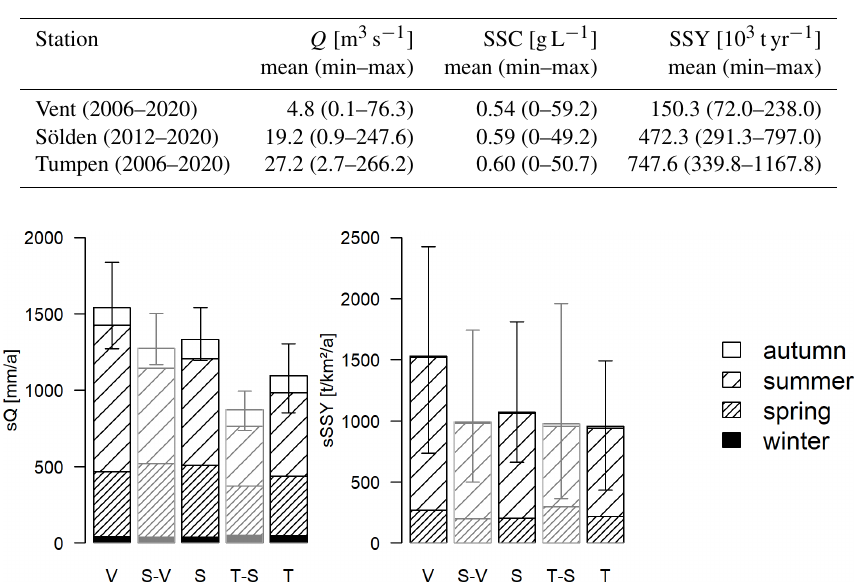
Table 3. Mean (min–max) observed values of discharge ( Q ), suspended sediment concentration (SSC) and suspended sediment yield (SSY) at the three gauges. For better comparability between the stations, SSCs recorded during the winter months from November to April were set to zero if there were NA values.